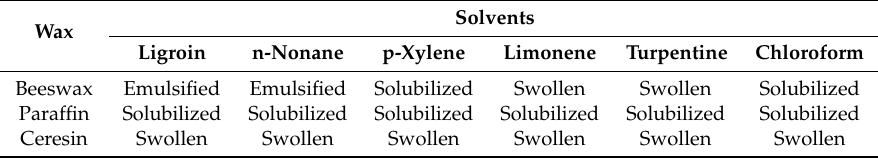
Table 1. Results of solubility tests performed on the three selected waxes.